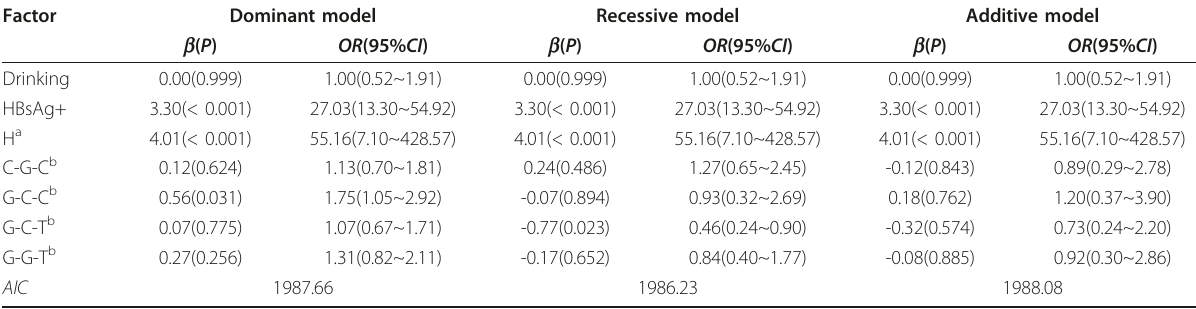
Table 6 Analysis of haplotypes and envioronments under different genetic models Factor Dominant model Recessive model